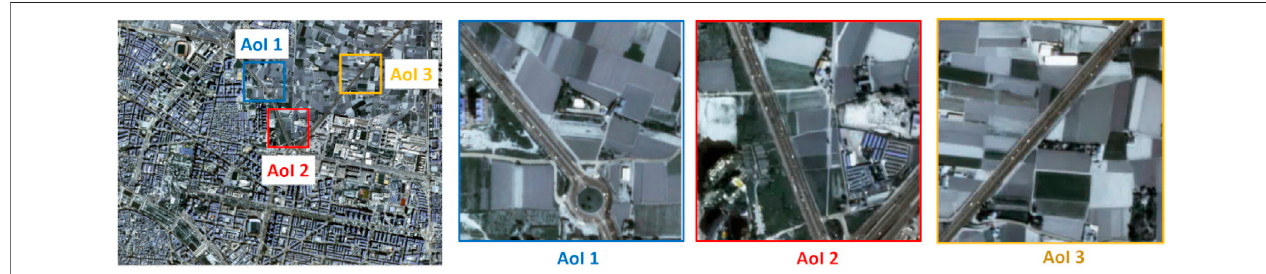
FIGURE 4 | Areas of interest (AoIs) for method evaluation.